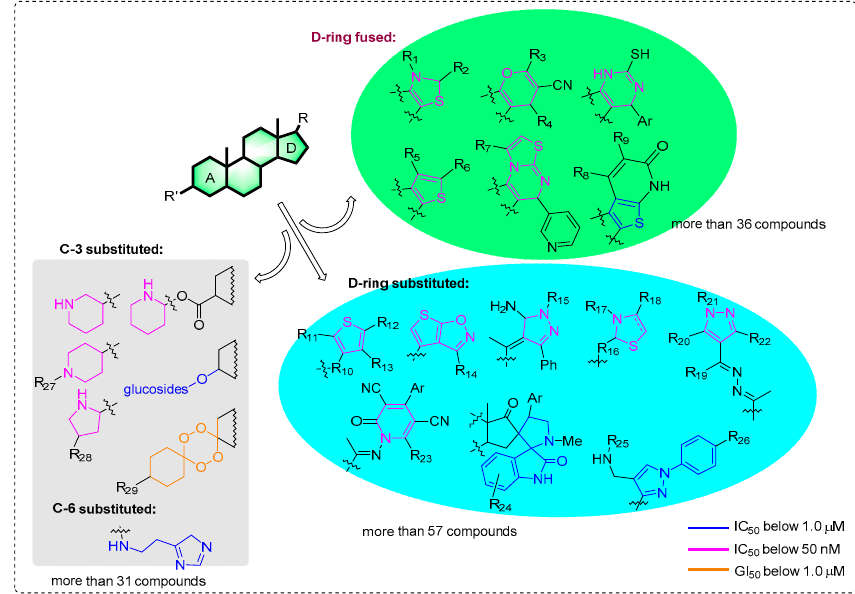
Figure 1. Current potential anticancer steroid stuctures with the IC50/GI50 values below 1.0 μ M.